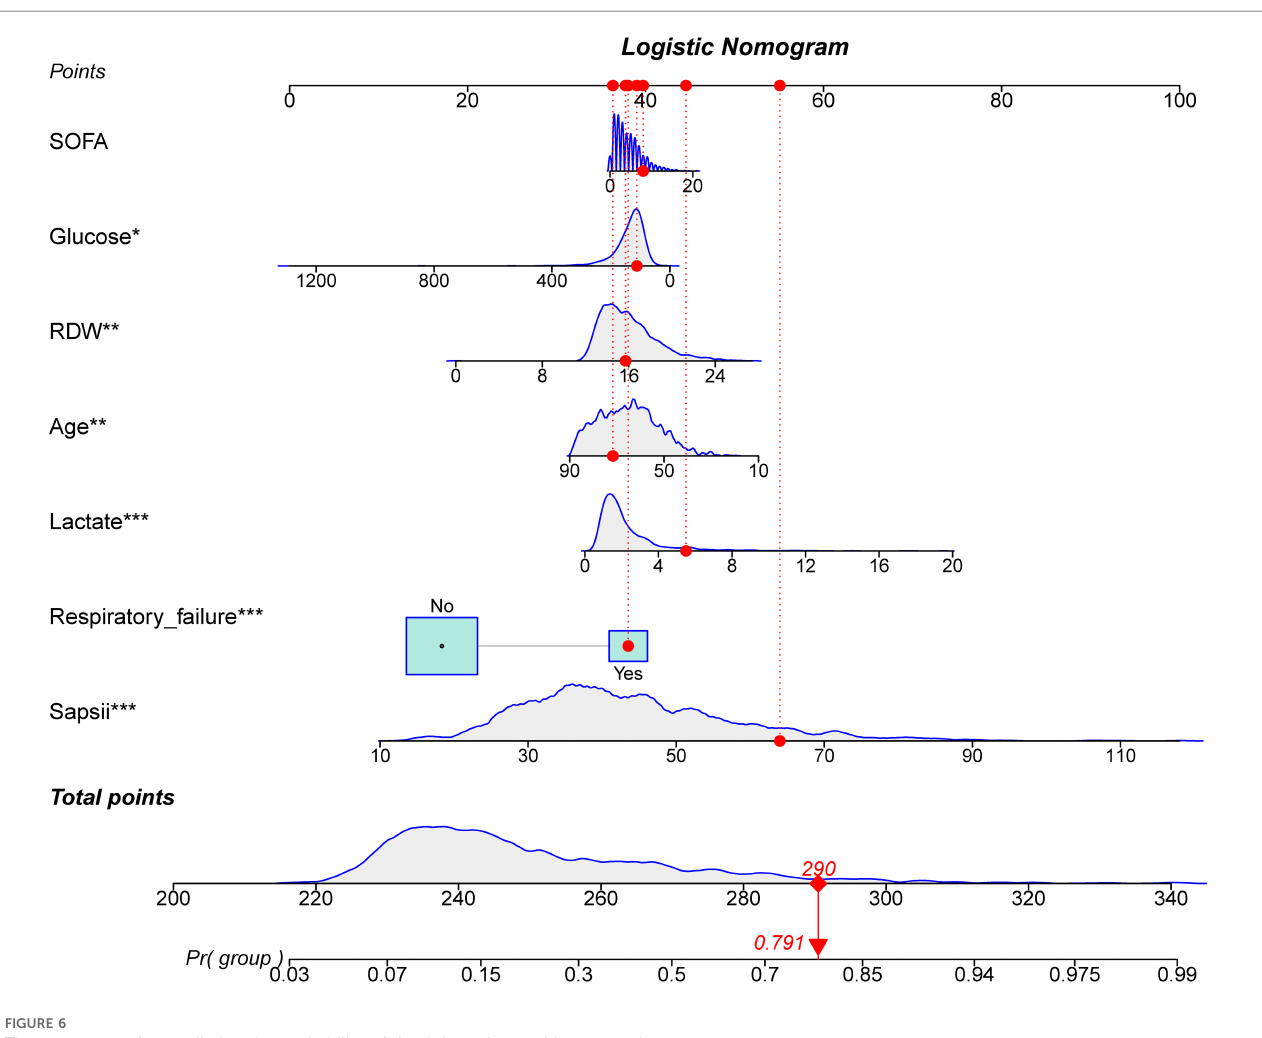
FIGURE 6 The nomogram for predicting the probability of death in patients with metastatic